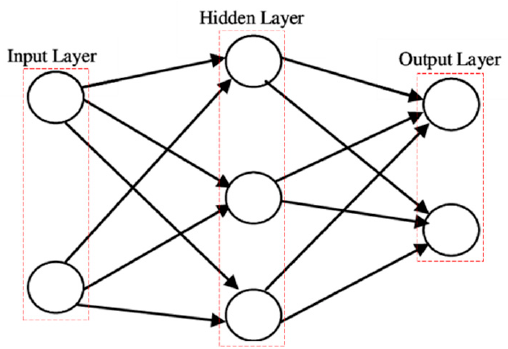
Figure 3. Architecture of BPNN.